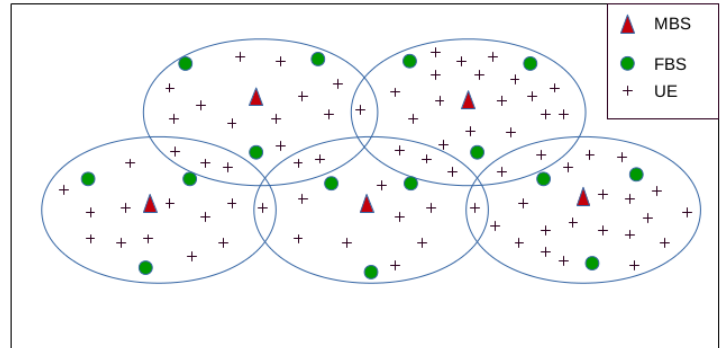
Figure 1. Simulation